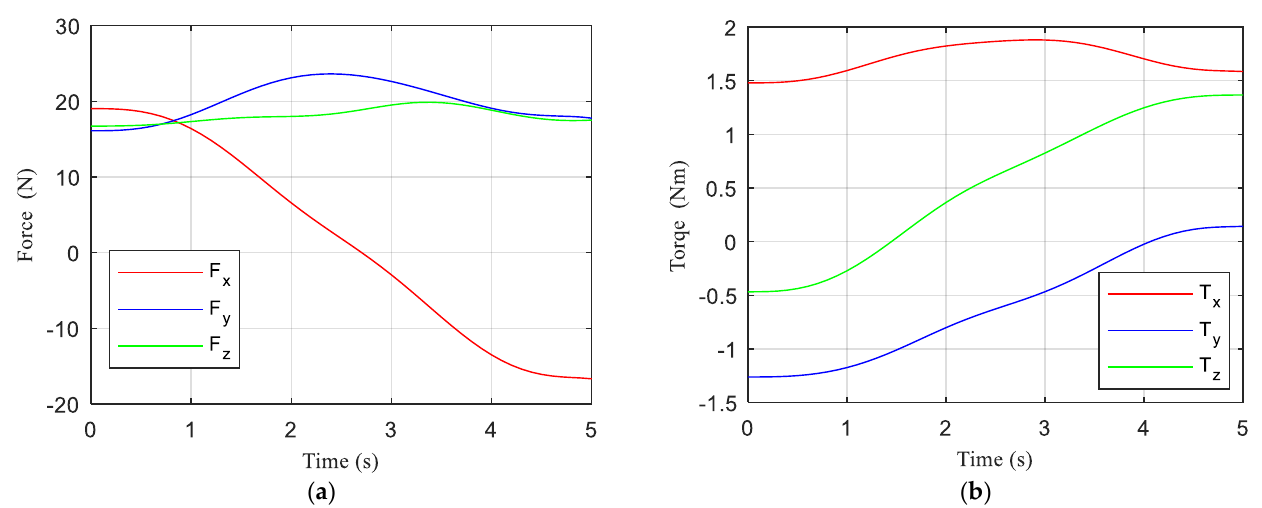
Figure 6. The real-time force/torque on the end effector of the humanoid manipulator. ( a ) The real-time force on the end effector; ( b ) The real-time torque on the end effector.